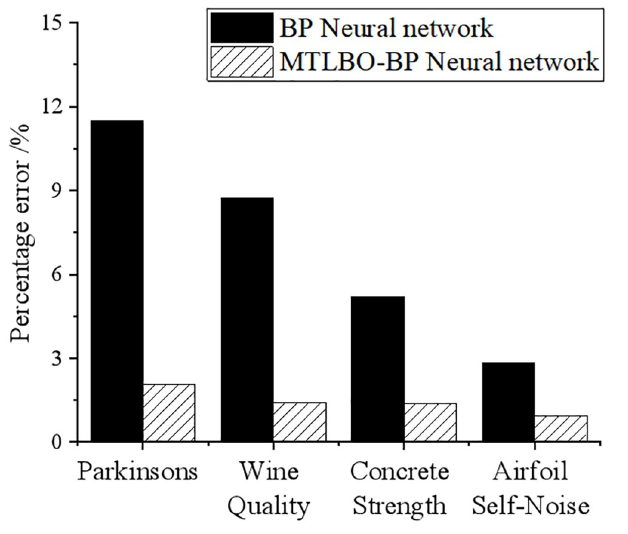
Fig 7. Prediction percentage